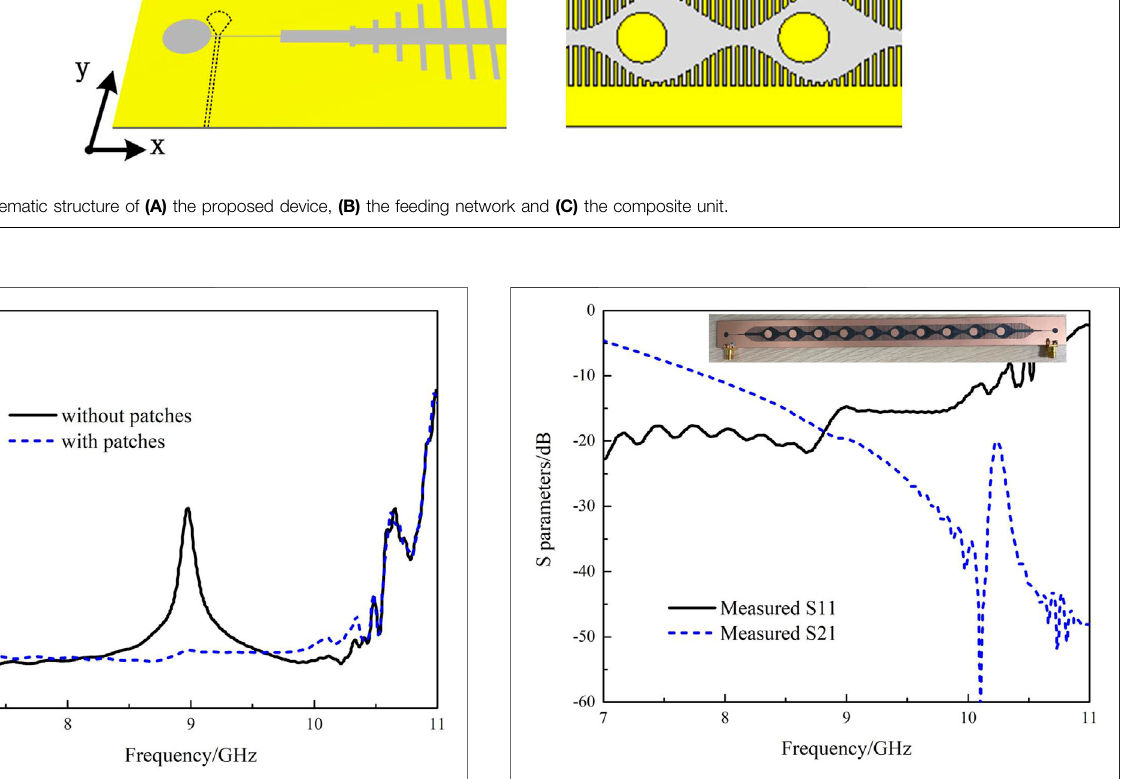
FIGURE 7 | VSWR of designs with and without parasitic patches. FIGURE 8 | Measured S parameters of the proposed design. Inset: Photo of the